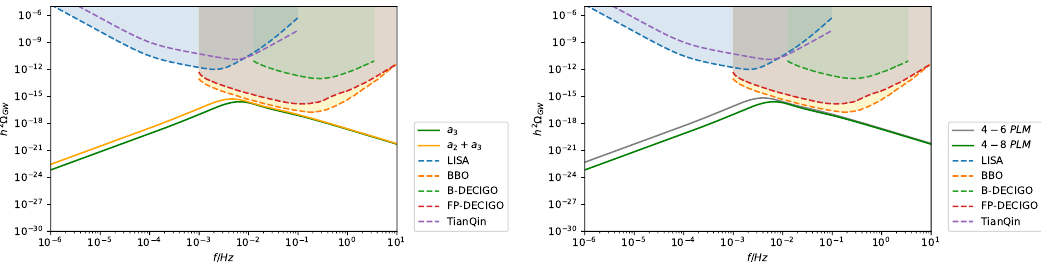
Figure 7 . Left panel: GW signals from 4-8 PLMs with a 2 = 0 (labelled by “ a 3 ”, corresponding to the category N = 4 ) and a = 0 (labelled by “ a + a ”, corresponding to the category N = 4 ), 1 2 6 2 3 2 corresponding to the fitting results in figure 3, for N = 4 with T = 270 MeV. Right panel: c comparison of the GW signals from the 4-6 PLM and 4-8 PLM with a = 0 , for N = 4 and 2 T c = 270 MeV. The SM contribution has been turned off by taking ζ = 0